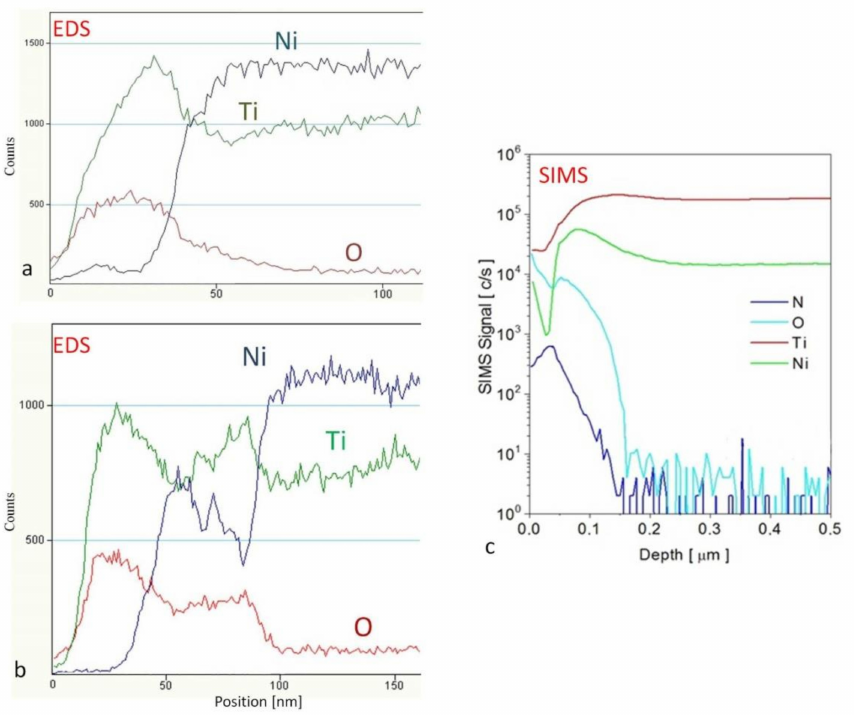
Figure 4. Distribution (via energy dispersive microanalysis (EDS)) of oxygen, nitrogen, nickel and titanium in the surface layers produced under glow discharge oxidation conditions without ( a ) and after initial cathodic sputtering ( b , c ), found using secondary ion mass spectrometry (SIMS). In the case of cathodic sputtering application, a thicker layer of titanium oxide was obtained (about 80 nm), while without sputtering, the layer’s thickness was about 40 nm (Figure 4), despite the application of less chemically active air (instead of oxygen) in the reactive atmosphere during plasma oxidation. From the thermodynamic point of view,